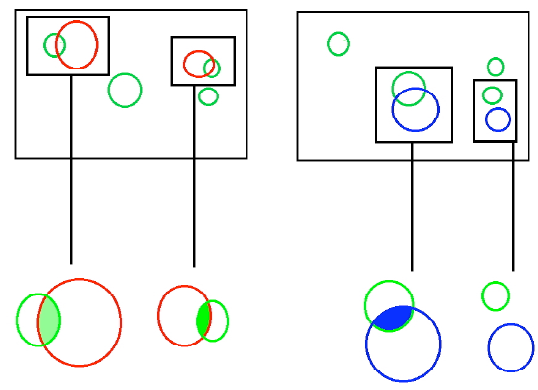
Figure 2 – Figure depicting the ‘overlap’, the dependent variable used in the analysis. Shaded areas show those regions where there is overlap; the number of pixels in the shaded region is the measure of similarity between model, aROIs, and participant,